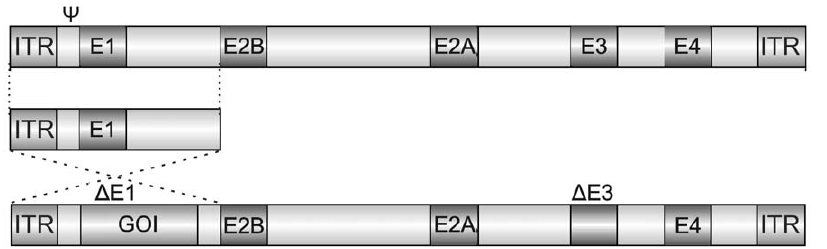
Figure 1. Homologous recombination of HEK293 Ad5 genomic DNA with the Ad construct. HEK293 cells contain bases 1–4345 of Human Ad serotype 5 genome, including the packaging signal ( y ) and E1 region. Overlapping Ad5 sequences in 2 nd generation Ad constructs can undergo single or double homologous recombination to yield replication competent Ad.